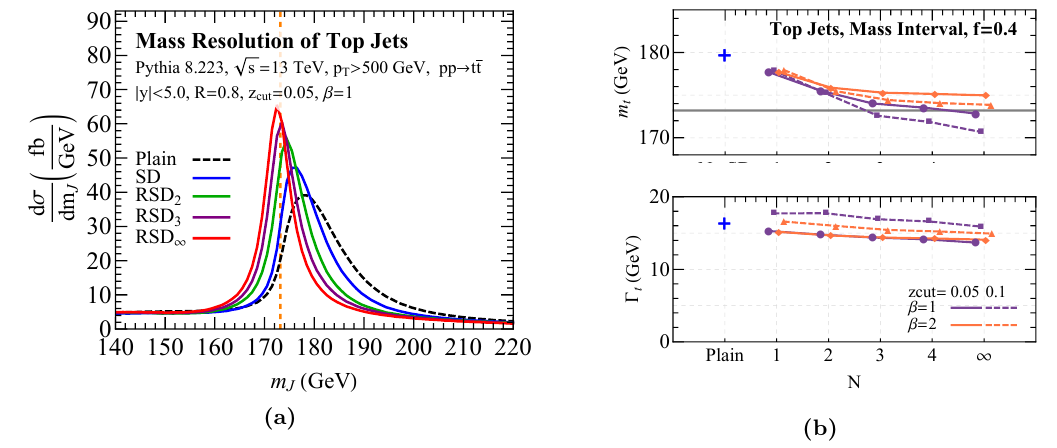
Figure 7. Same as (cid:12)gure 6 but for the top jet